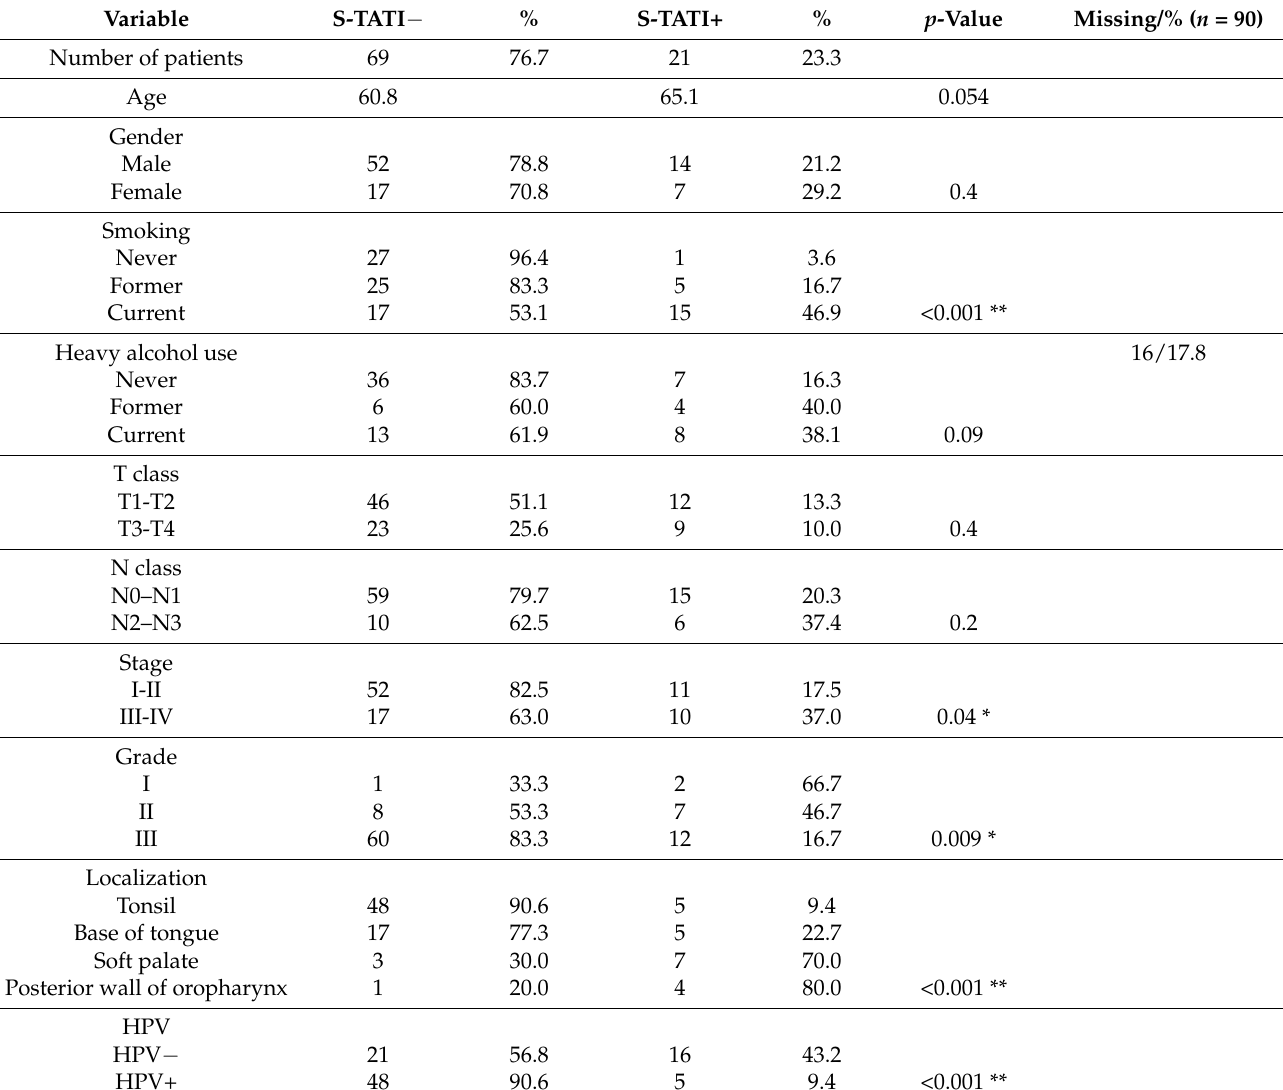
Table 1. Clinicopathological data according to